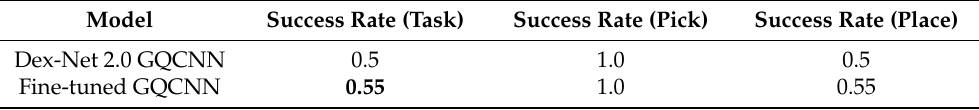
Table 2. Evaluation of our fine-tuned GQCNN against the Dex-Net 2.0 pre-trained GQCNN for depth images generated from a camera with the different extrinsic parameters from the training setup.